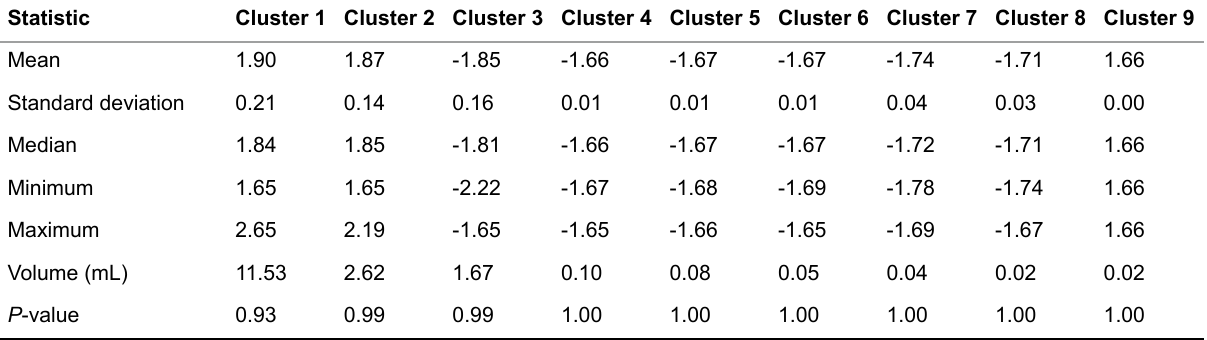
Table 4. Summary statistics for clusters identified in population template using MIMneuro ® voxel analysis. Parameters were a P -value of 1 minimum volume of 0 mL, and minimum z-score of 1.65